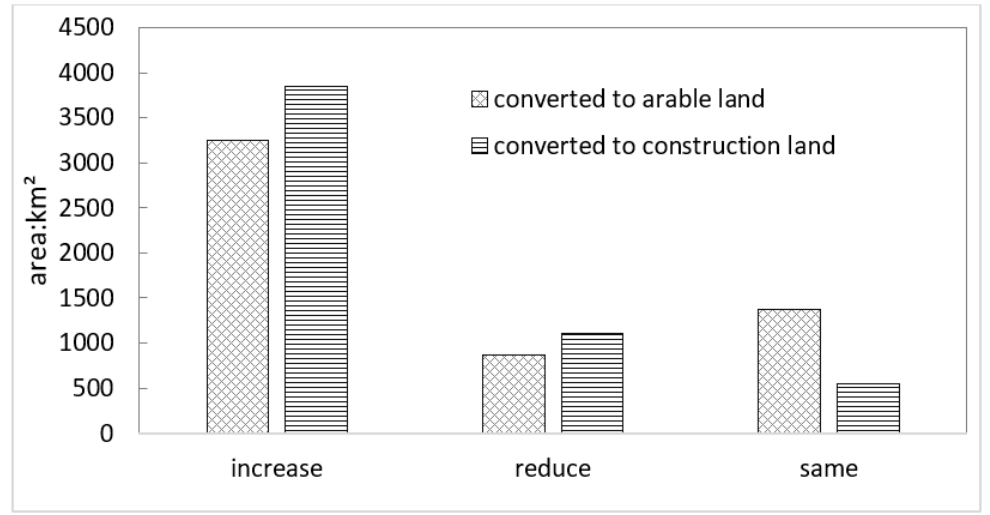
Figure 7. Land use type conversions and ecological risk changes from 2000 to 2020.